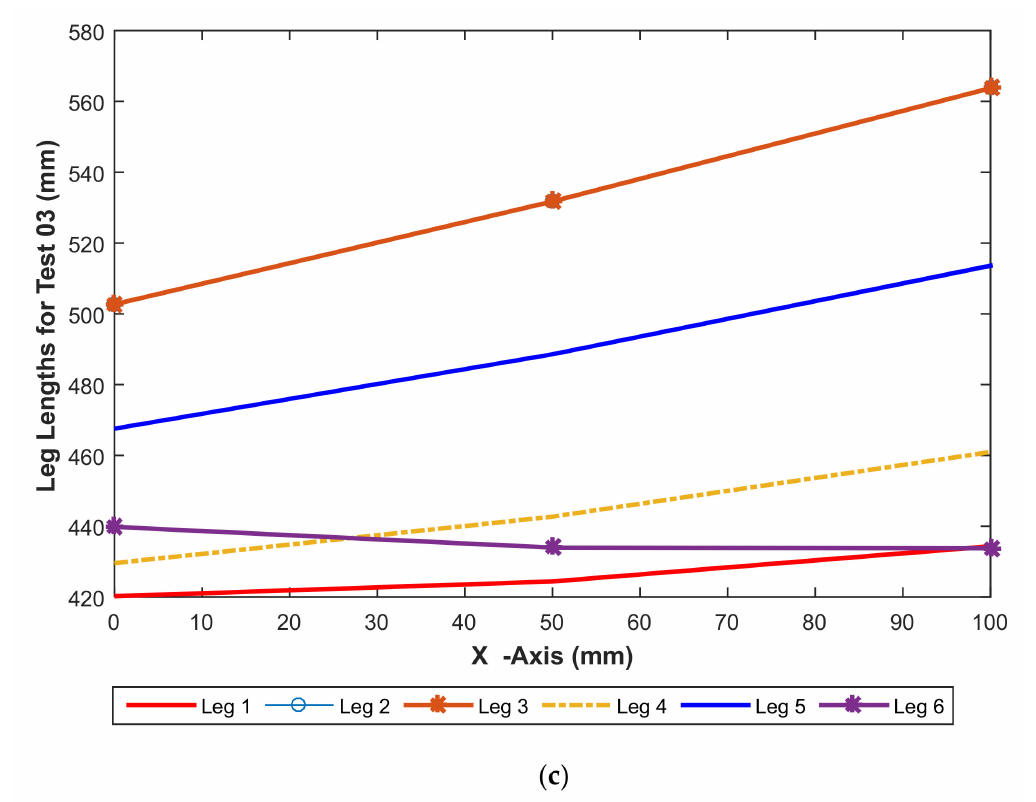
Figure 10. ( a ). Leg Length obtained for test 01 (Leg 2 and Leg 3 have same lengths); ( b ). Leg Length obtained for test 02 (Leg 2 and Leg 3 have same lengths); ( c ). Leg Length obtained for test 03 (Leg 2 and Leg 3 have same lengths).